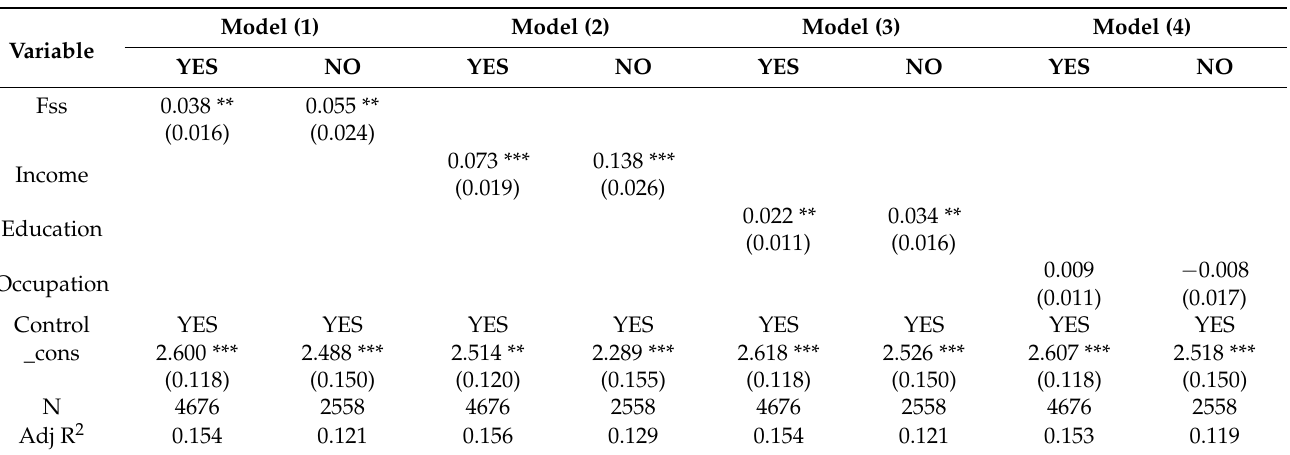
Table 6. The heterogeneous effect of the Health Course.